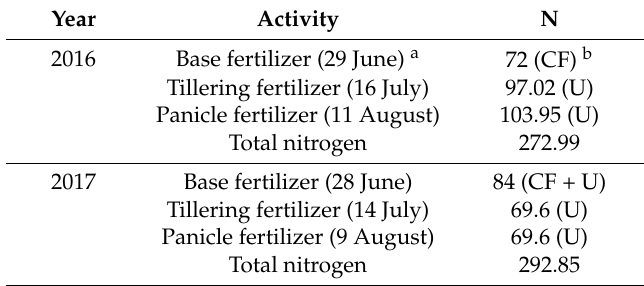
Table 2. Date and rate of nitrogen fertilization during the rice-growing season (kg N ha − 1